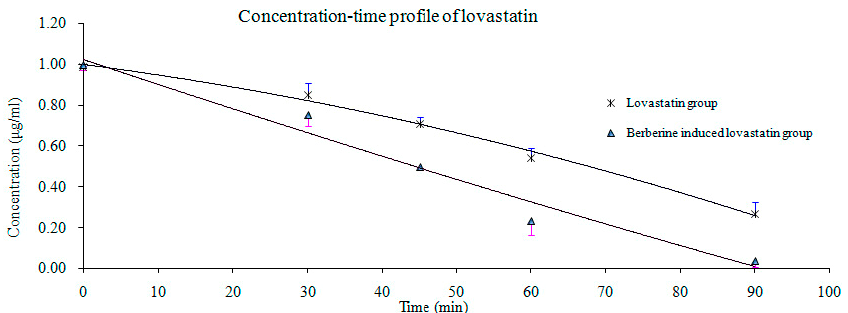
Figure 4. HepG2 cell metabolism of lovastatin plotted by drug concentration-time profile.